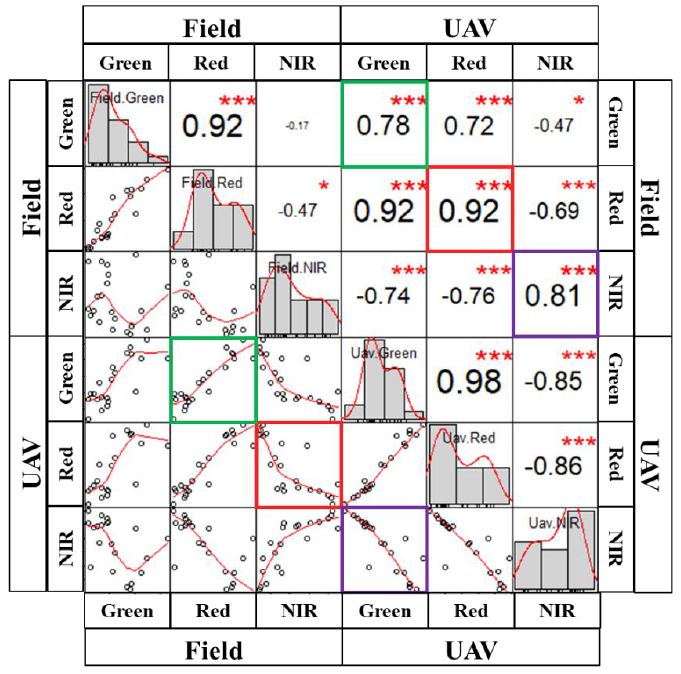
Figure 11. Correlation between the UAV images and on-site spectroradiometer survey results for each band.